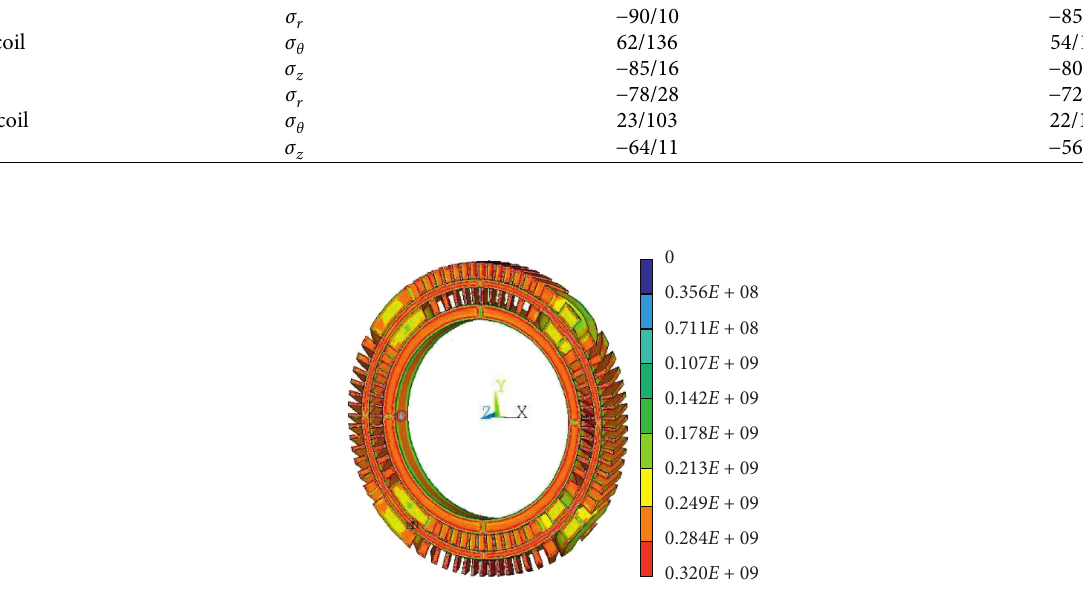
Figure 11: The radial (a) and azimuthal (b) stress distributions on the conductors with loads of thermal contraction and Lorentz force. Table 4: The stress of conductor (in MPa). Cooldown to 4.2K Operation at 0.4kA